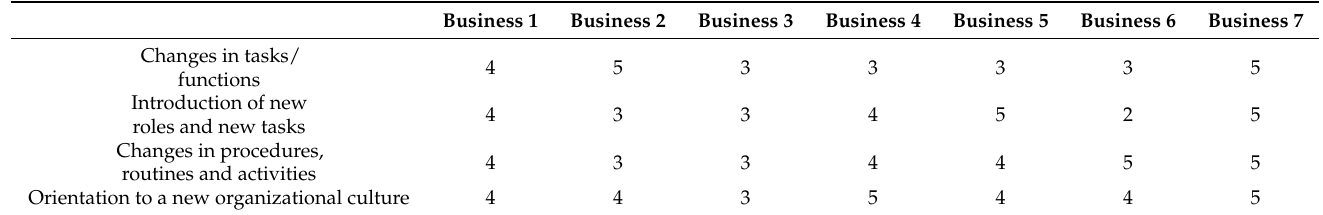
Table 4. Companies perception on the impact of the use of 3D printers in the medical sector at an organizational